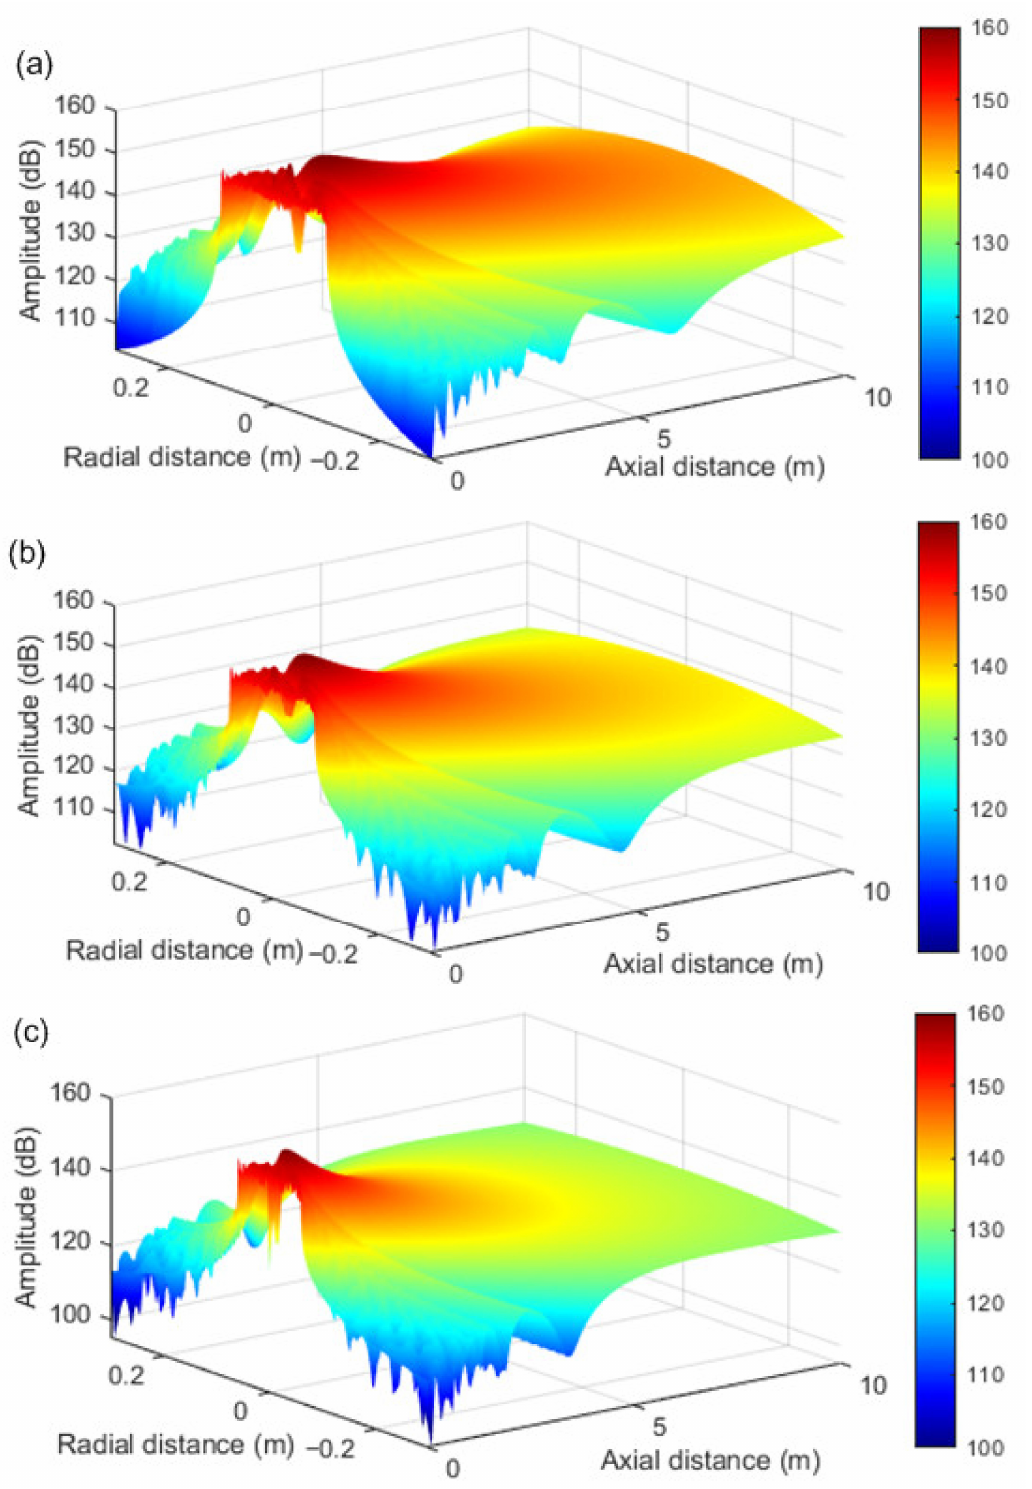
Figure 4. Sound field distribution of parametric array loudspeaker with different diameters. ( a ) 0.17 m in diameter; ( b ) 0.14 m in diameter; ( c ) 0.11 m in